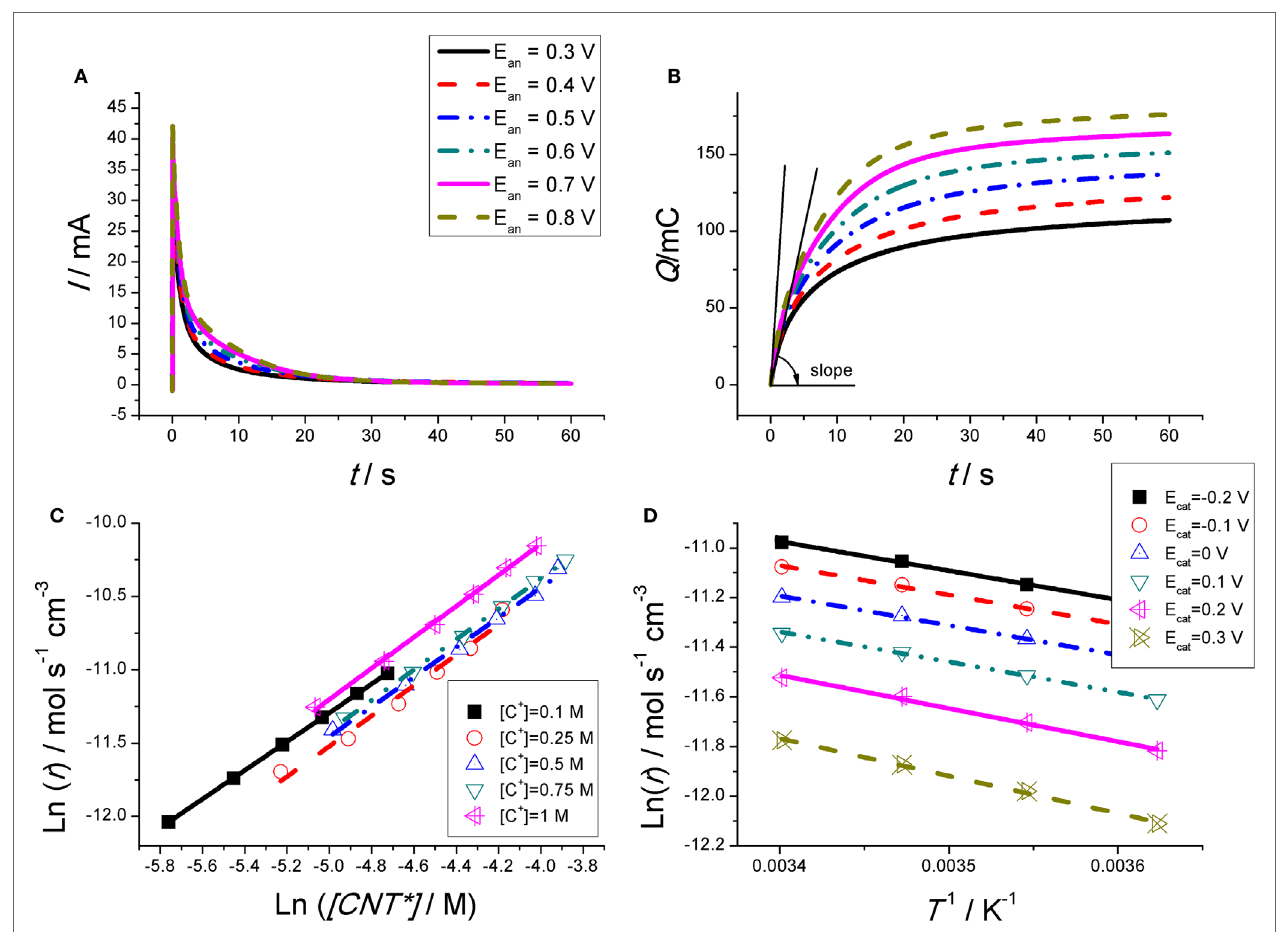
FiGURe 2 | (A) Anodic chronoamperometric responses obtained from the second consecutive square potential wave at room temperature from CNT films submitted to consecutive square potential waves from − 1100 mV (versus Ag/AgCl), kept for 60 s each time, to different potentials (300, 400, 500, 600, 700, and 800 mV), kept for 60 s every time in 0.1 M aqueous TEABF 4 solution. (B) Consumed charge obtained by integration of the experimental chronoamperograms from (A) . (C) Double-logarithmic plot of the experimental oxidation rates for different concentrations of active centers during oxidation of the CNT film, obtained from the initial slopes in (B) . (D) Arrhenius plot for oxidation of the CNT film in 0.1 M TEABF 4 aqueous solution at 3, 9, 15, and 21°C. The reaction rates were obtained by potential steps between different cathodic potentials and 600 mV. Reproduced from Martinez et al. (2012), with permission from